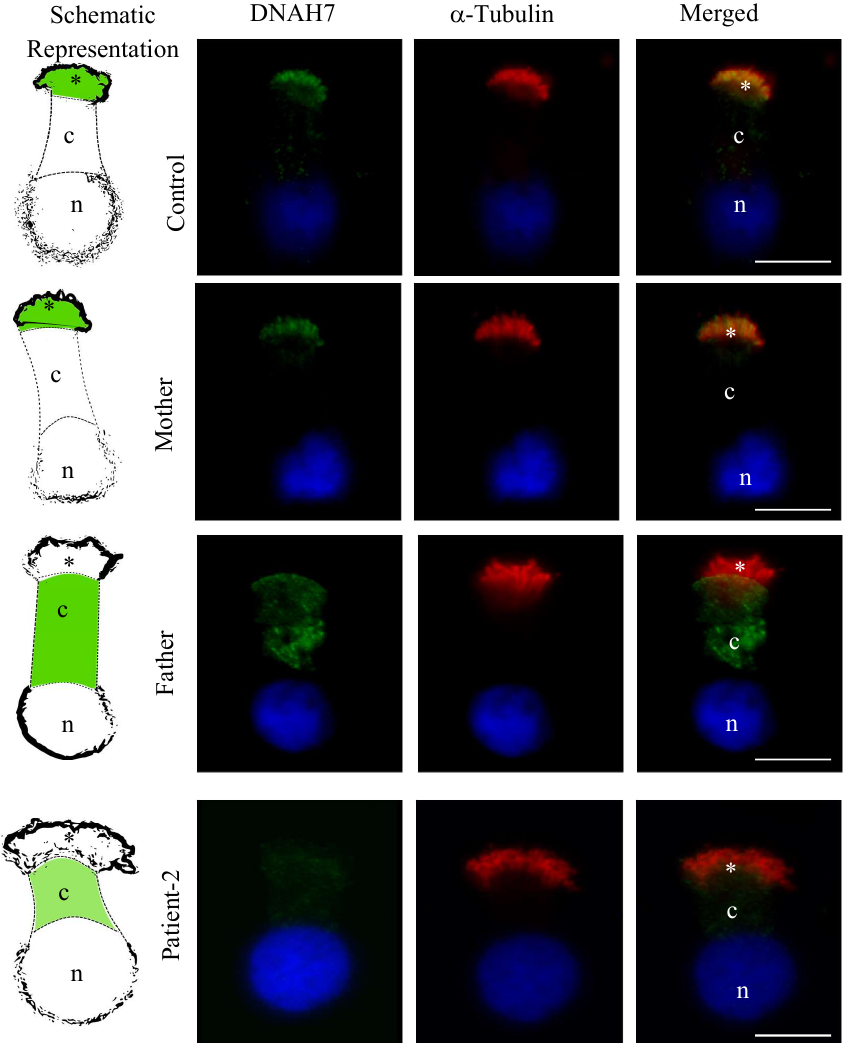
Figure 7. Expression and localization of specific DNAH7 protein by immunofluorescence in respiratory epithelialcellsfromhealthyvolunteers(Control), bothparentsofPatient-2(MotherandFather)andPatient-2. Staining with anti-DNAH7 antibodies (green) and with antibodies against axoneme-specific acetylated α -tubulin (red). Nuclei stained with DAPI (blue). Schematic representation at left to better localize the staining (DNAH7 in intense or faint green). * = cilia; c = cytoplasm; n = nuclei. Scale bars = 10 µ